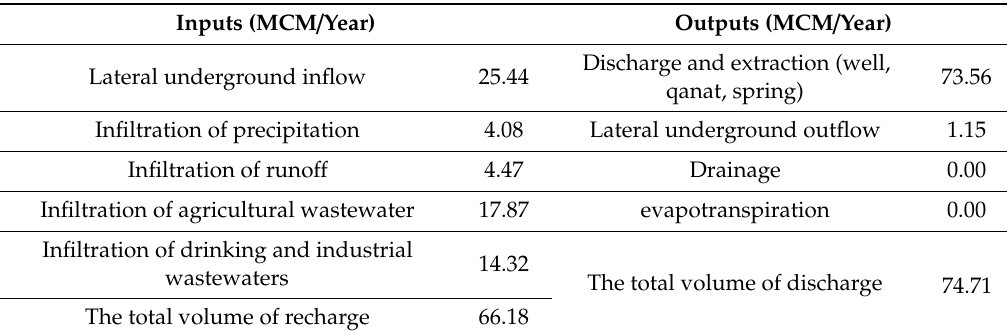
Table 1. Birjand aquifer budget provided by RWCSK [64]. The values are in million cubic meters (MCM) per year.